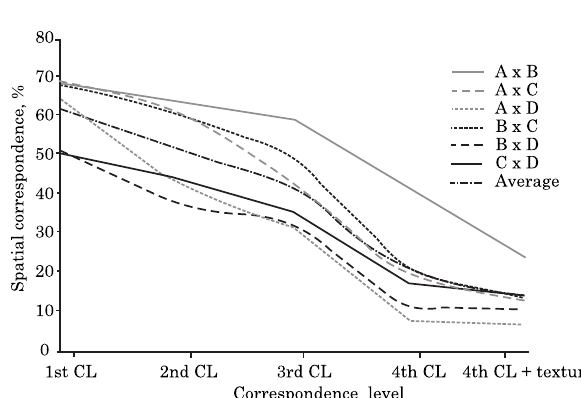
Figure 4. Spatial correspondence between conventional soil maps.